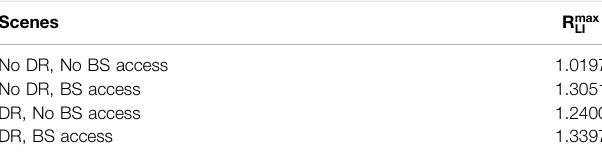
TABLE 4 | Critical rate of load growth in the isolated micro-grid under various scenarios. Scenes R max